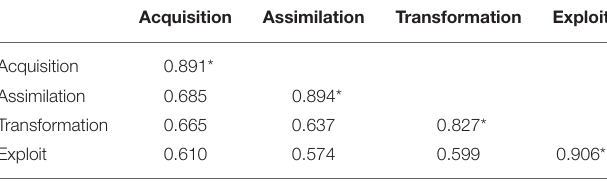
TABLE 4 | Discriminant validity of absorptive capacity.